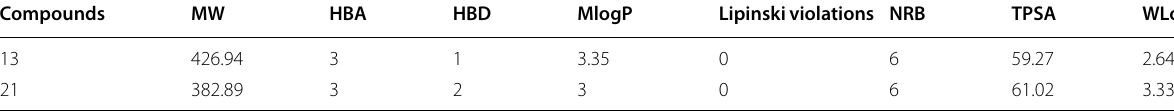
Table 11 Physicochemical properties of compounds 13 and 21 Compounds